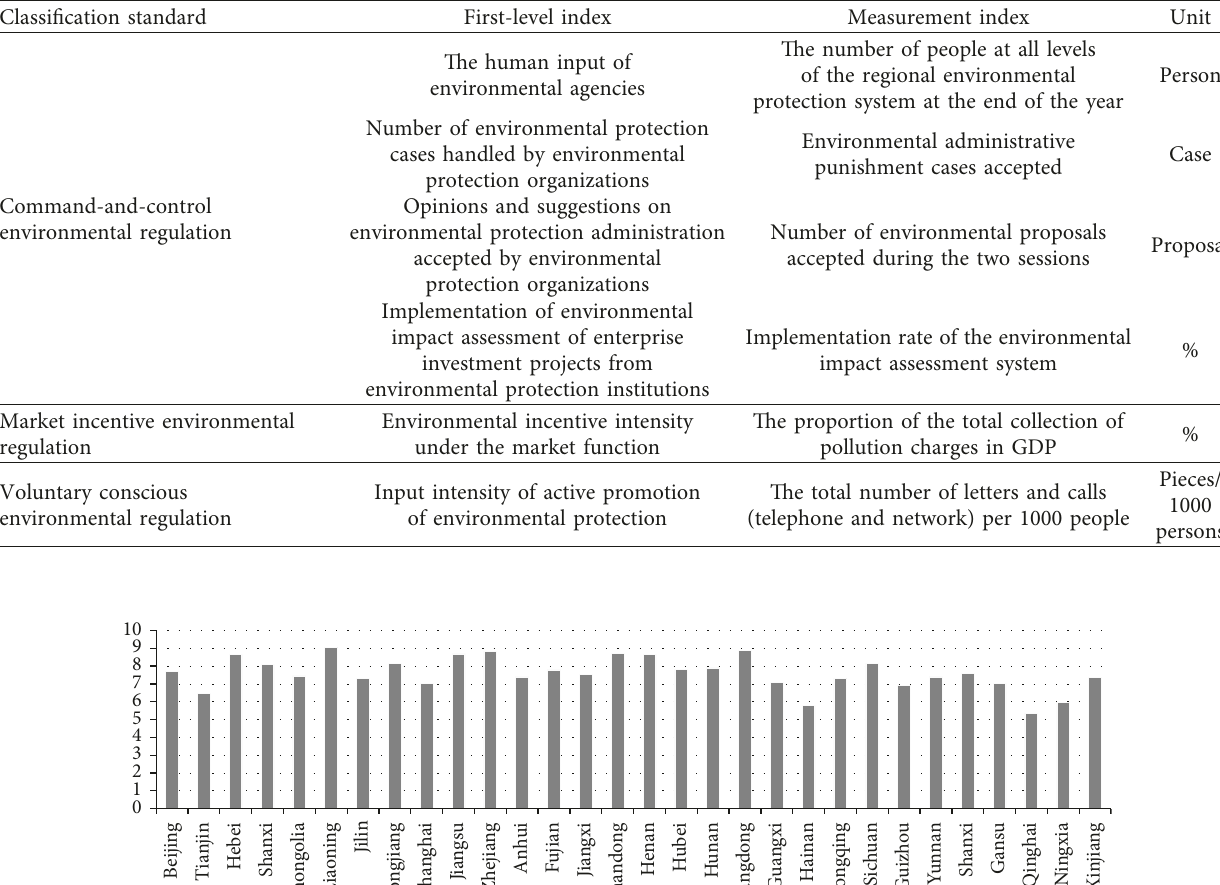
Table 2: Classification and measurement of environmental